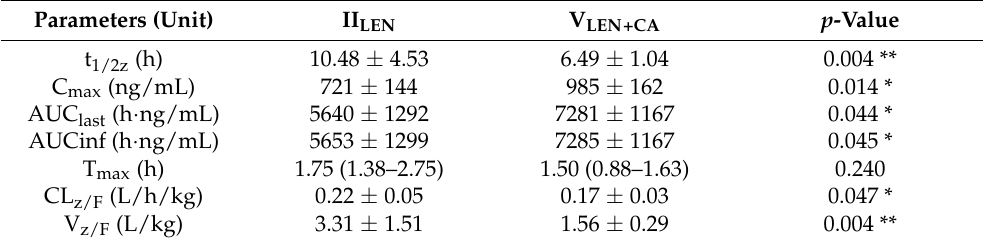
Figure 5. The mean plasma concentration–time curves of lenvatinib after oral administration. Each data point represents the mean ± standard deviation (n = 6). Ⅱ LEN , lenvatinib (1.2 mg/kg); Ⅴ LEN+CA , lenvatinib (1.2 mg/kg) oral co-administered with canagliflozin (10 mg/kg). Table 6. Pharmacokinetic parameters of lenvatinib in rat plasma after oral administration of single dose lenvatinib (1.2 mg/kg) and combined with canagliflozin (10 mg/kg); n = 6 for each group. Parameters (Unit)